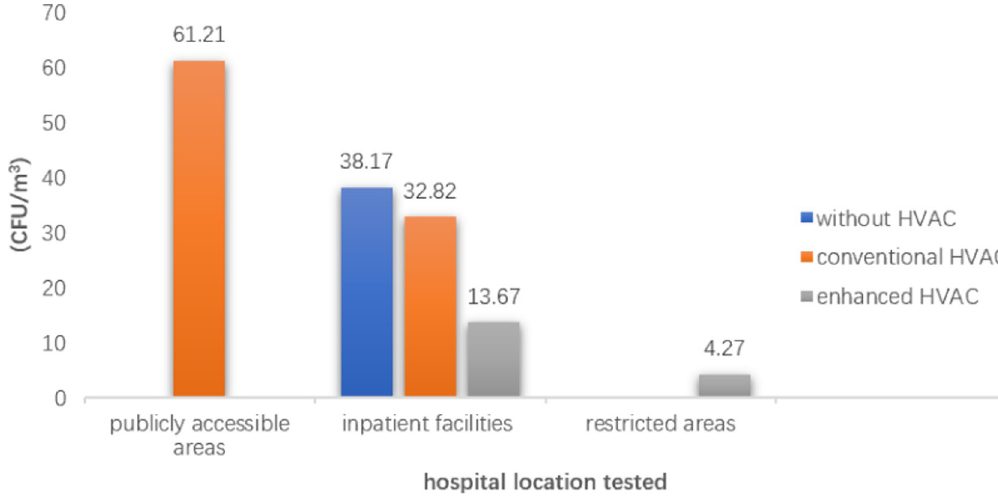
Fig 5. Mean fungal colony forming units per cubic meter (CFU/m 3 ) in